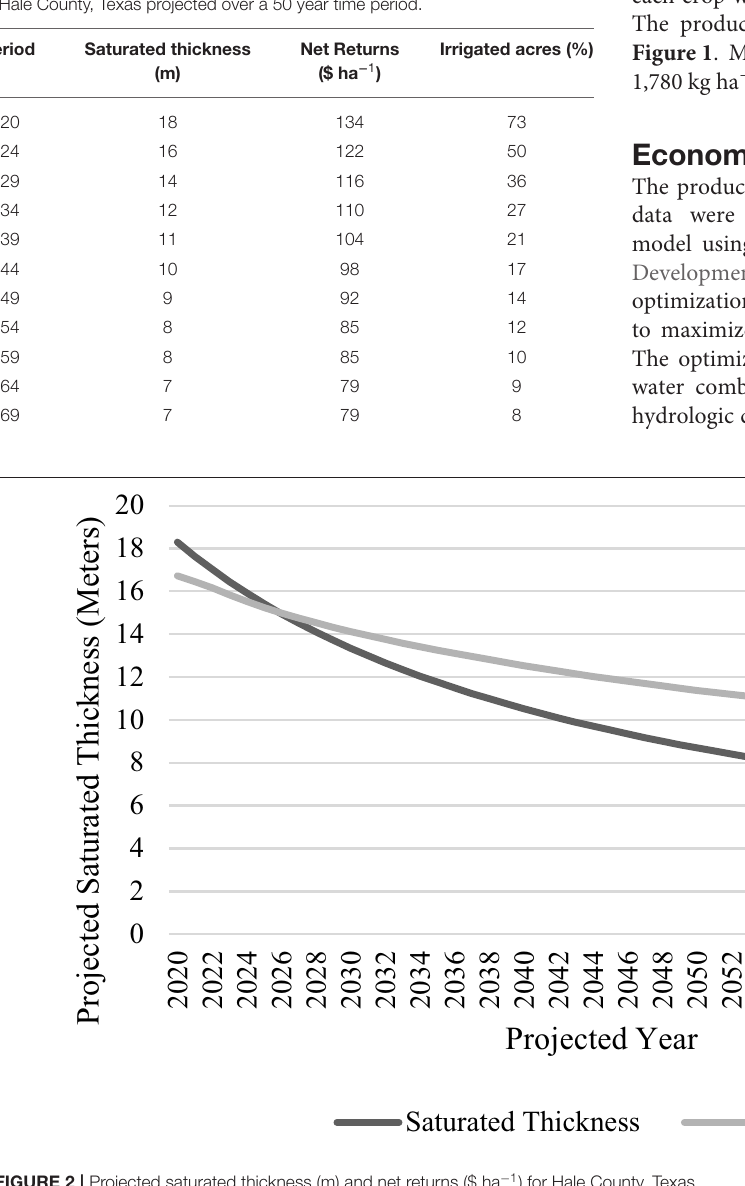
Frontiers in Sustainable Food Systems |